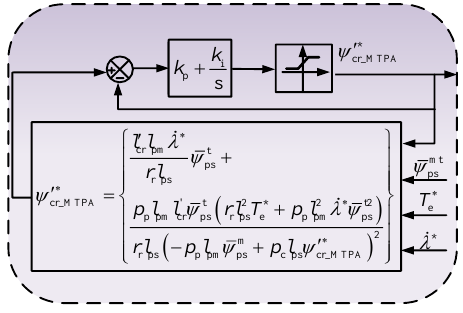
Figure 2. MTPA online computing block diagram.